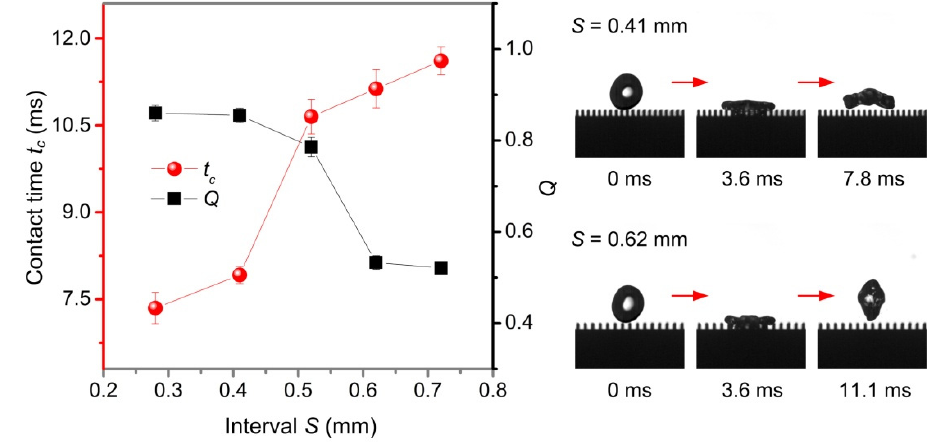
Figure 9. Contact time t c and Q of water droplets in a three-level structured plane surface as a function of interval S .